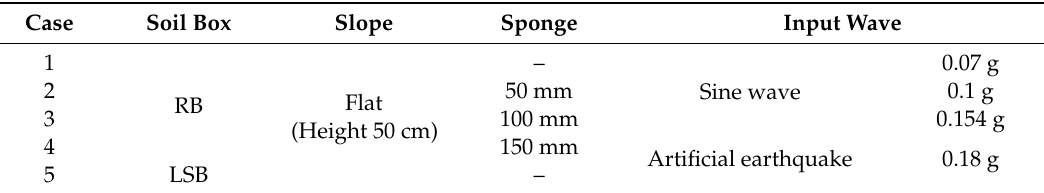
Table 2. Classification of test model and input wave.